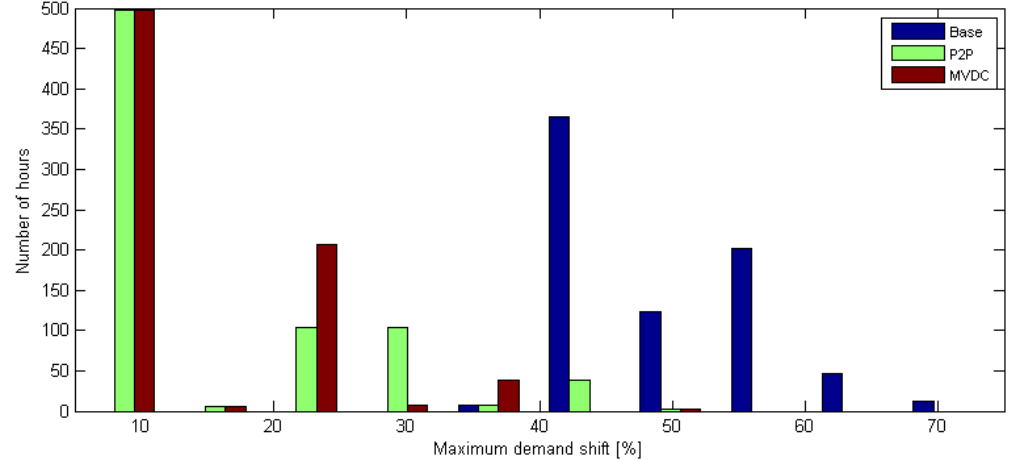
Figure 8. The distribution of maximum demand shift within the study